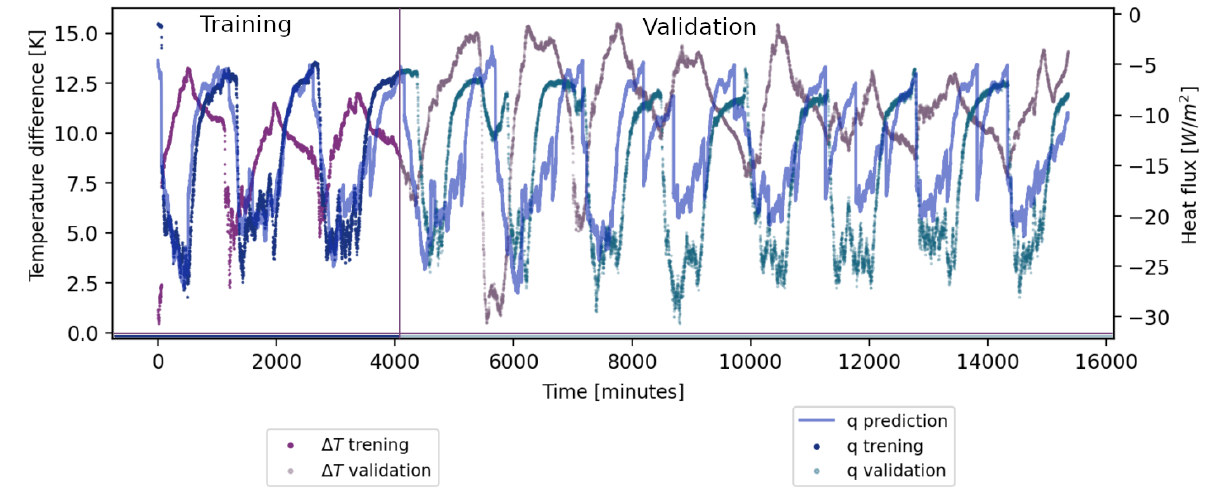
Figure 10. Results for the deep-learning model developed for the pilot in-situ